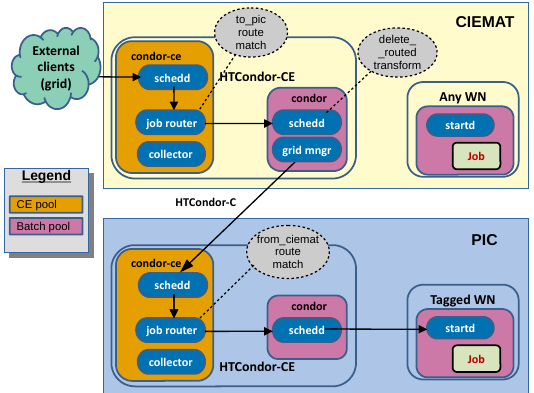
Figure 1: Overview of HTCondor job re-routing mechanism ( CIEMAT to PIC